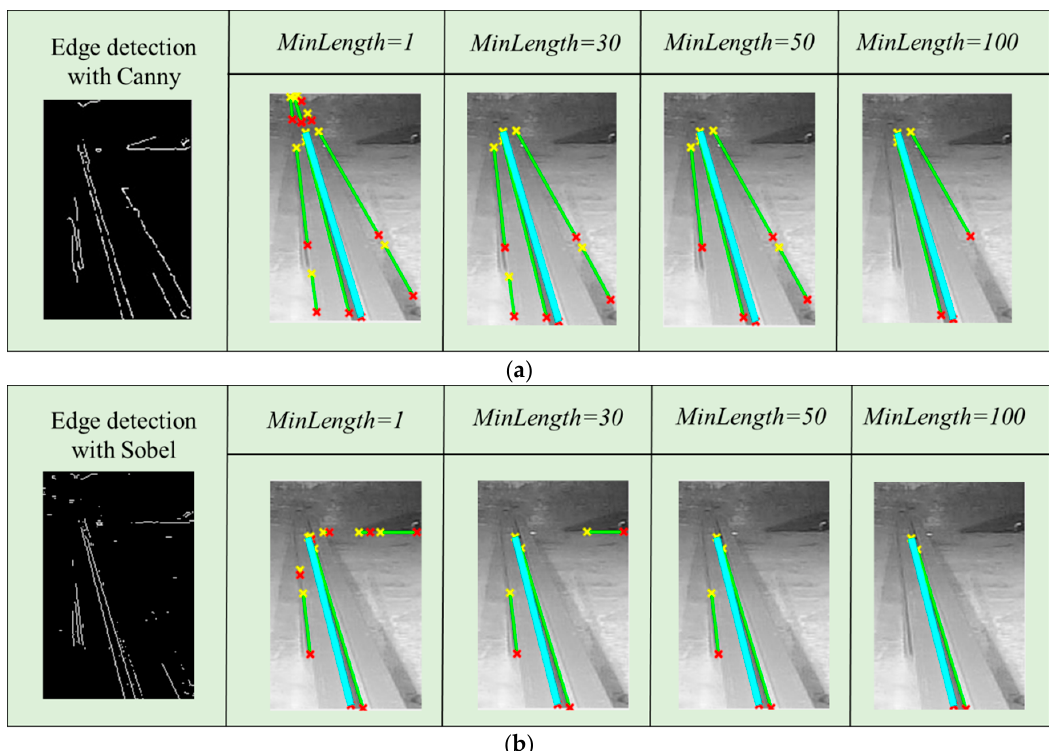
Figure 17. ( a ) Canny edge detector; and ( b ) Sobel edge detector in the out-of-water environment with different MinLength values.